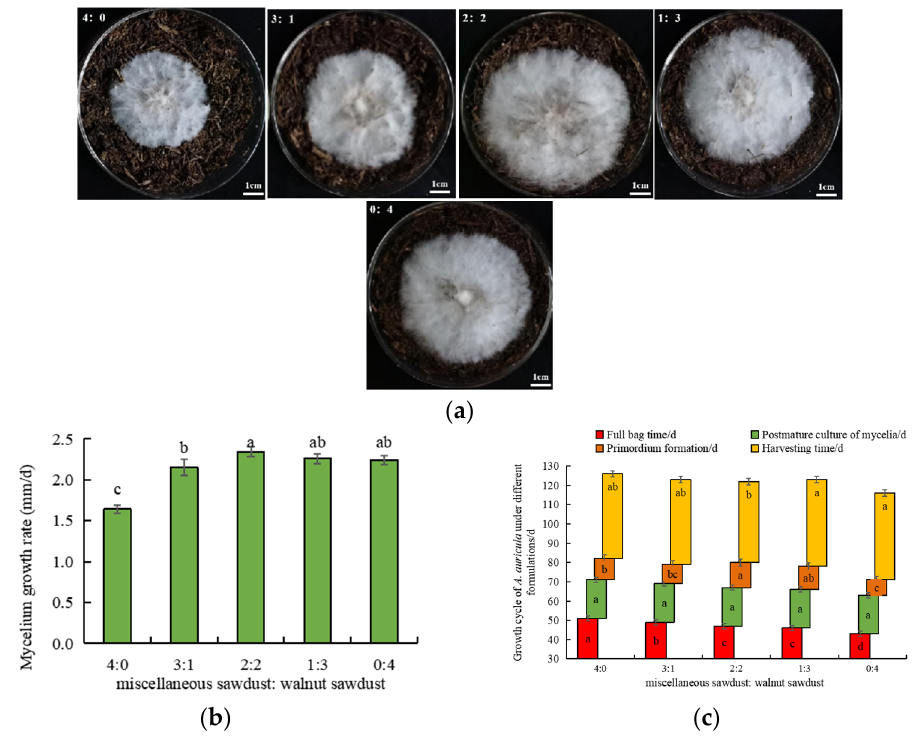
Figure 3. ( a ) Mycelia growth status, ( b ) mycelia growth rate and ( c ) growth cycle of A. auricula on substrate ratio was 4:0; 3:1; 2:2; 1:3 and 0:4. Different lowercase letters within each column are significantly different at p < 0.05 between treatments.